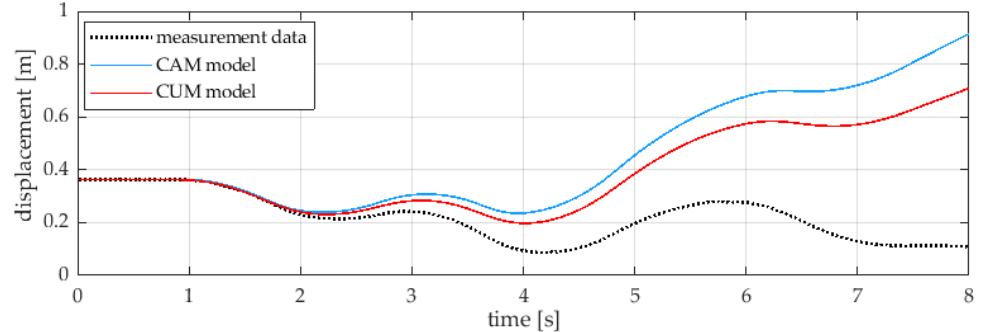
Figure 4. Ball displacement as a function of time and comparison of waveforms from experimental data with CAM and CUM numerical models.